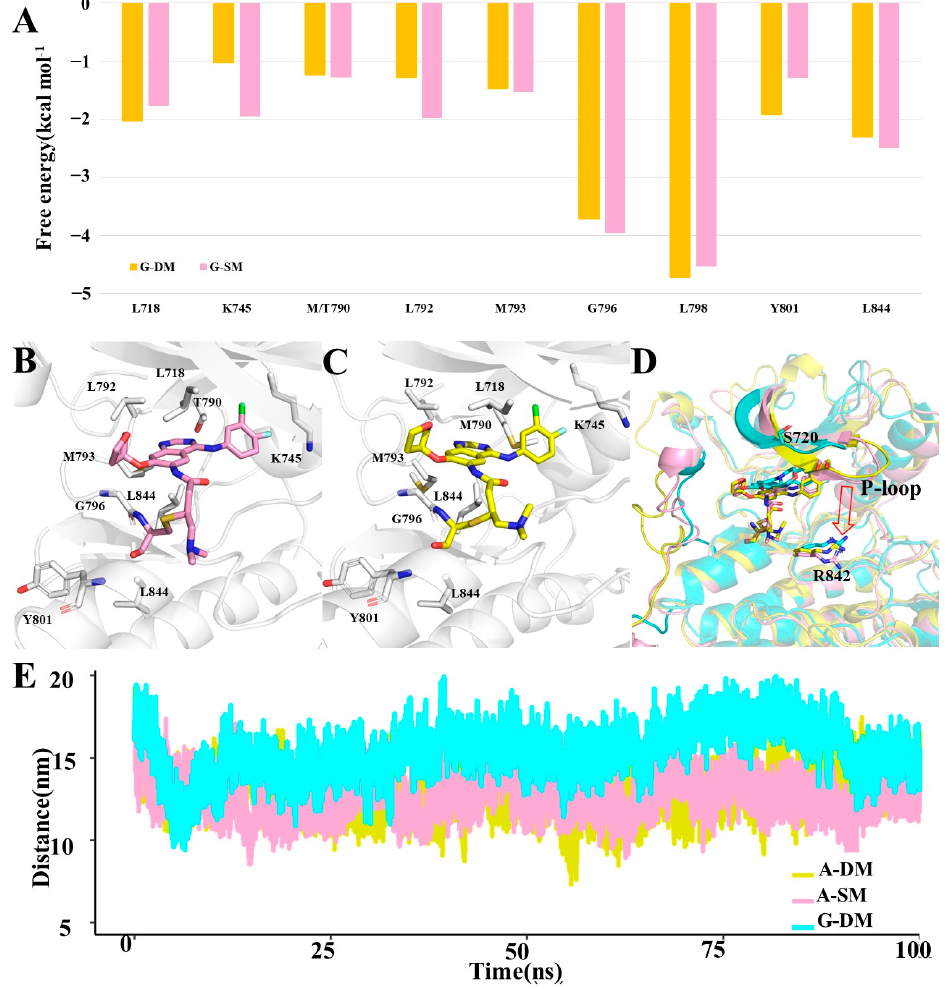
Figure 6. ( A ) Key residues identified by energy decomposition, which contributed more than 1.0 kcal mol − 1 in both A-SM and A-DM systems. ( B ) The clustered structure of Afatinib with SM (A-SM system). Key residues are represented by white sticks. Afatinib is represented by the yellow stick. ( C ) The clustered structure of Afatinib with DM (A-DM system). Gefitinib is represented by the pink stick. ( D ) The aligned structure of the G-DM (yellow), A-SM (pink), and A-DM (cyan) system. S720 and R842 are shown as sticks. ( E ) The distance fluctuations between the mass center of S720 and L842 in G-DM, A-SM, and A-DM